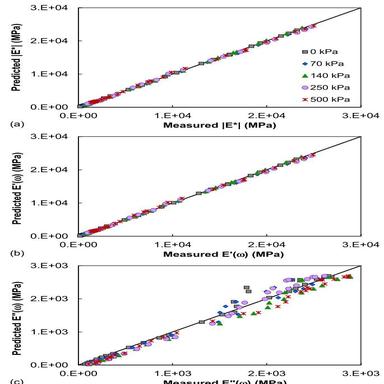
Comparison of the measured and predicted moduli in the arithmetic scale (Mix A): a) dynamic modulus, b) storage modulus, and c) loss modulus.